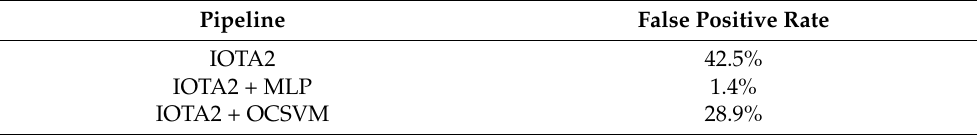
Table 5. False positive rate of the baseline pipeline and the multi-classifier